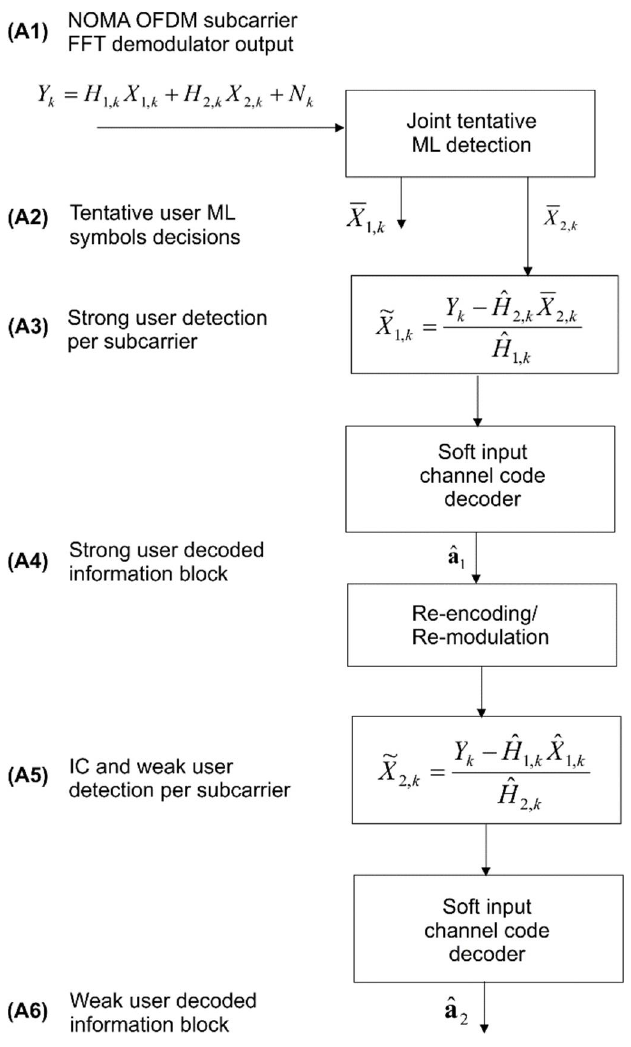
Figure 5. Block diagram of the algorithm for detection of the signals received in the multiple access phase by the relay.